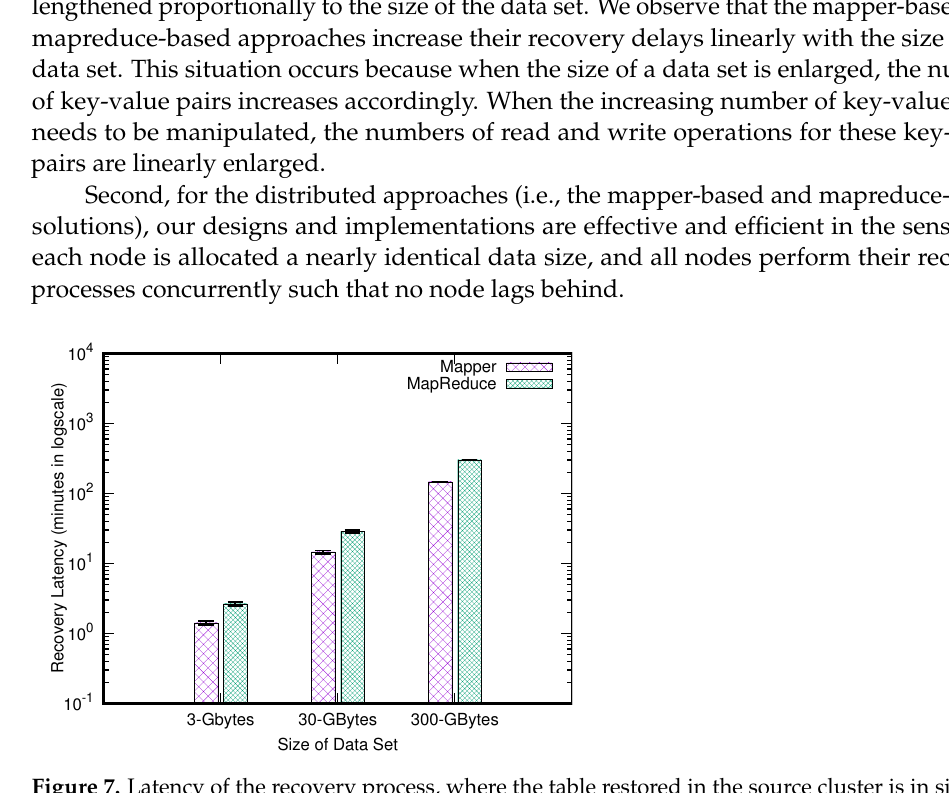
Figure 7. Latency of the recovery process, where the table restored in the source cluster is in size of 3 to 300